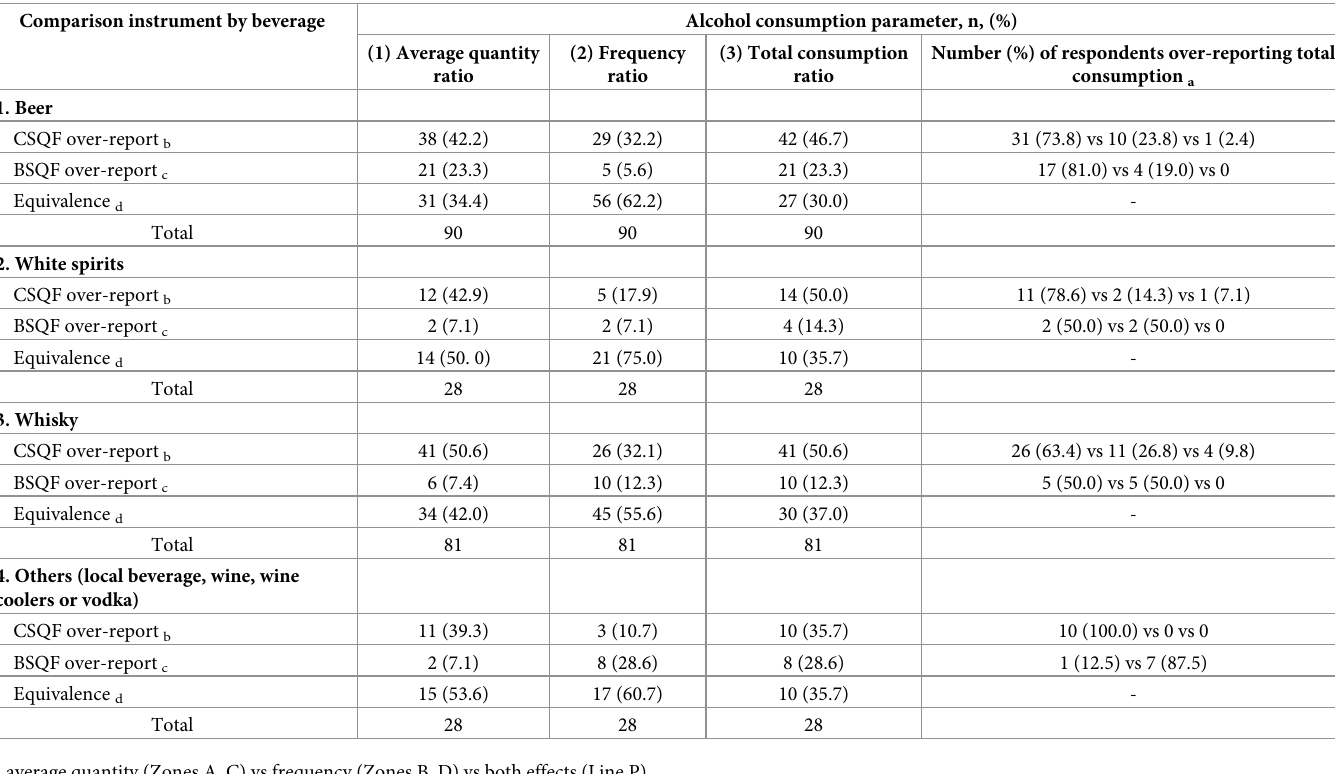
Table 3. Comparisons of frequency, average quantity, and total consumption ratios reported using different instruments (CSQF and BSQF) within the same participant. Comparison instrument by